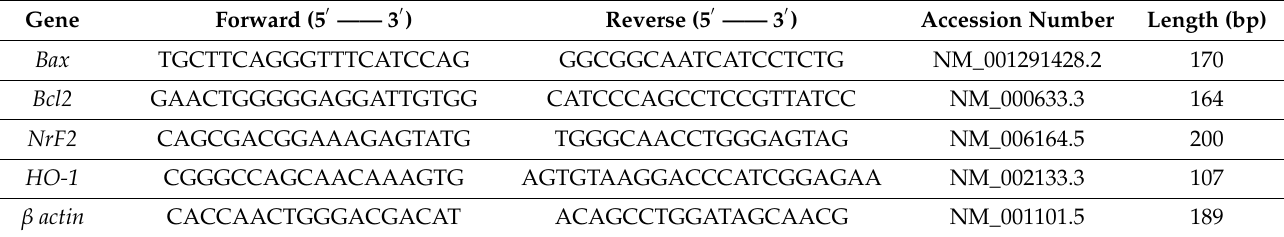
Table 1. Primers used for qPCR.